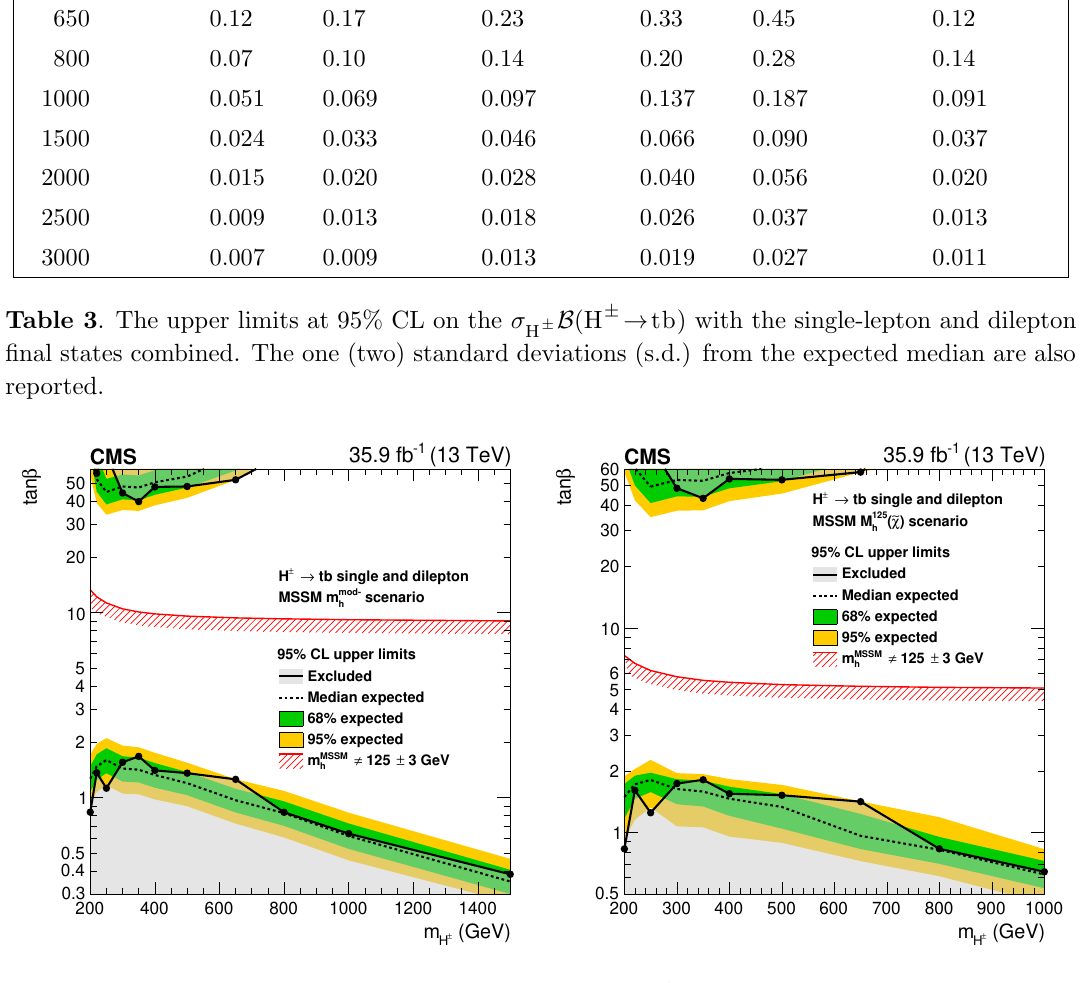
Figure 6 . Excluded parameter space regions in the m mod (cid:0) scenario (left) and in the M 125 h (~ (cid:31) ) h scenario (right). The grey area delimited by the solid black line and markers represents the observed excluded region. The dashed black line and the green (yellow) regions represent the median expected exclusion regions and one (two) standard deviations from the expected median, respectively. The region below the red line is excluded assuming that the observed neutral Higgs boson is the light CP-even 2HDM Higgs boson with a mass of 125 3 GeV, where the uncertainty is the theoretical (cid:6) uncertainty in the mass calculation.